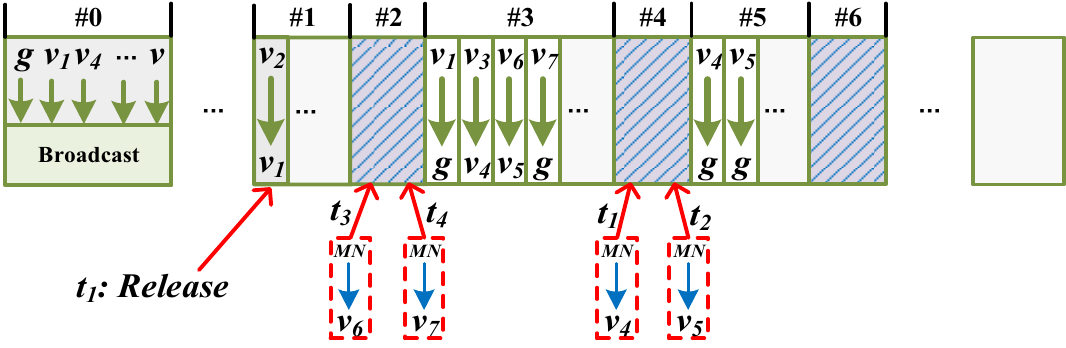
Figure 8. The structure of the superframe and the adjustment when MN moves from time t 0 to t 4